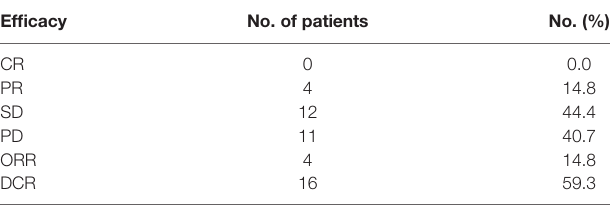
TABLE 2 | Ef fi cacy of apatinib in the treatment of 27 DMPM patients. Ef fi cacy No. of patients No. (%)